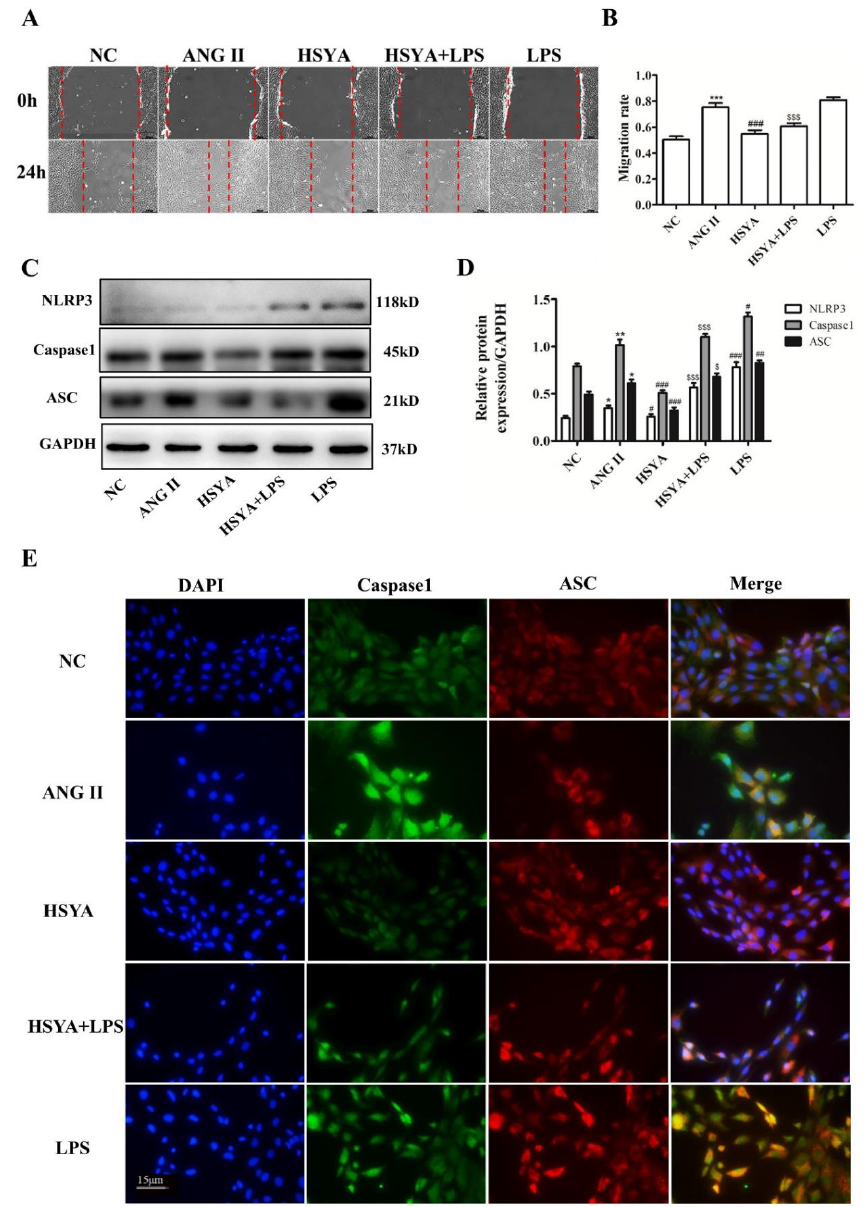
Figure 3. HSYA inhibited ANG II-induced VAF migration through inhibition of NLRP3 inflamma- some activation. ( A ) Wound-healing assay of VAFs treated or untreated with ANG II, HSYA, and LPS ( n = 3). Scale bar, 200 µm. ( B ) The quantification of the VAF mobility in the five groups of ( A ). ( C ) The expression of NLRP3-inflammasome-related proteins analyzed via Western blot. ( D ) The quantification of the protein blots in ( C ). ( E ) Effects of HSYA on LPS-induced coexpression of Caspase1 (green) and ASC (red) ( n = 3). Scale bar, 15 µm. * Compared with the NC group, # com- pared with the ANG II group, $ compared with the LPS group, * /#/$ p < 0.05, ** / ## p < 0.01, *** / ###/$$$ p < 0.001.